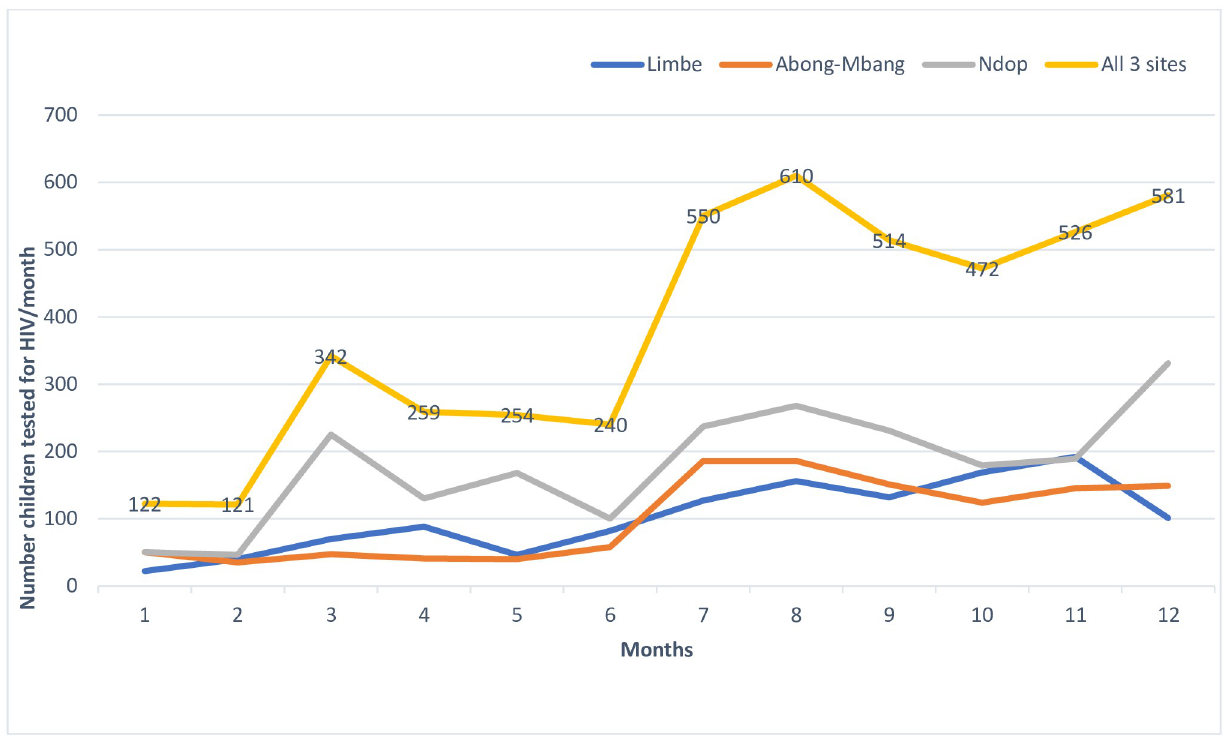
Fig 1. Trends in the number of children/adolescents tested for HIV before and after the intervention.